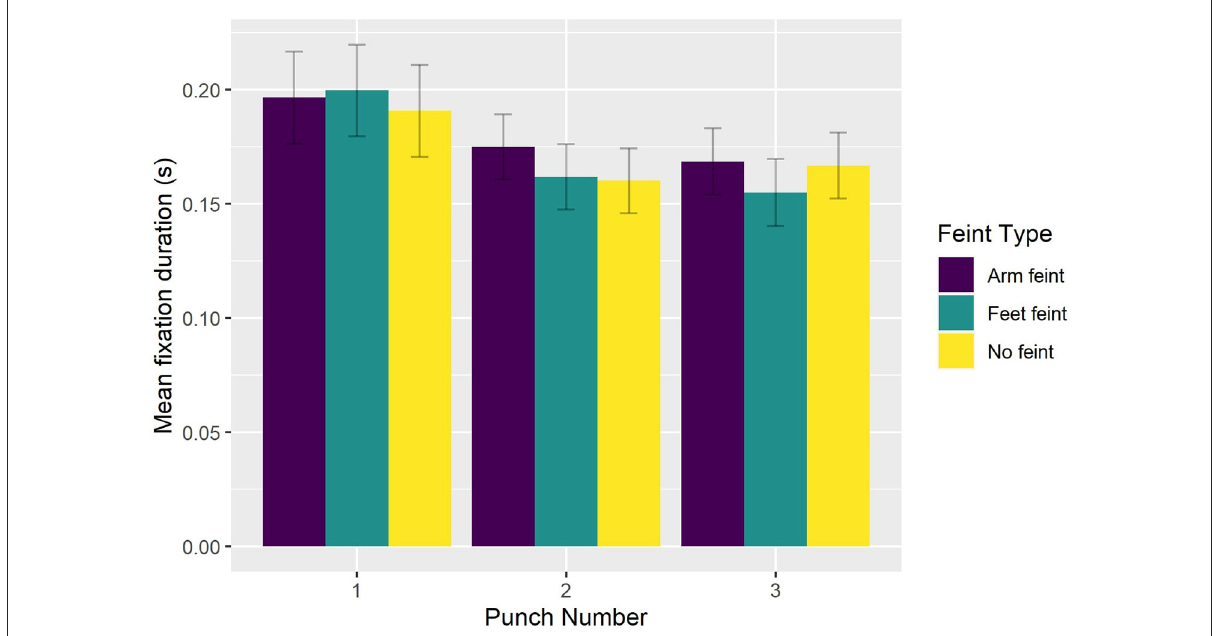
FIGURE7 Group mean fixation duration as a function of Feint Type and Punch